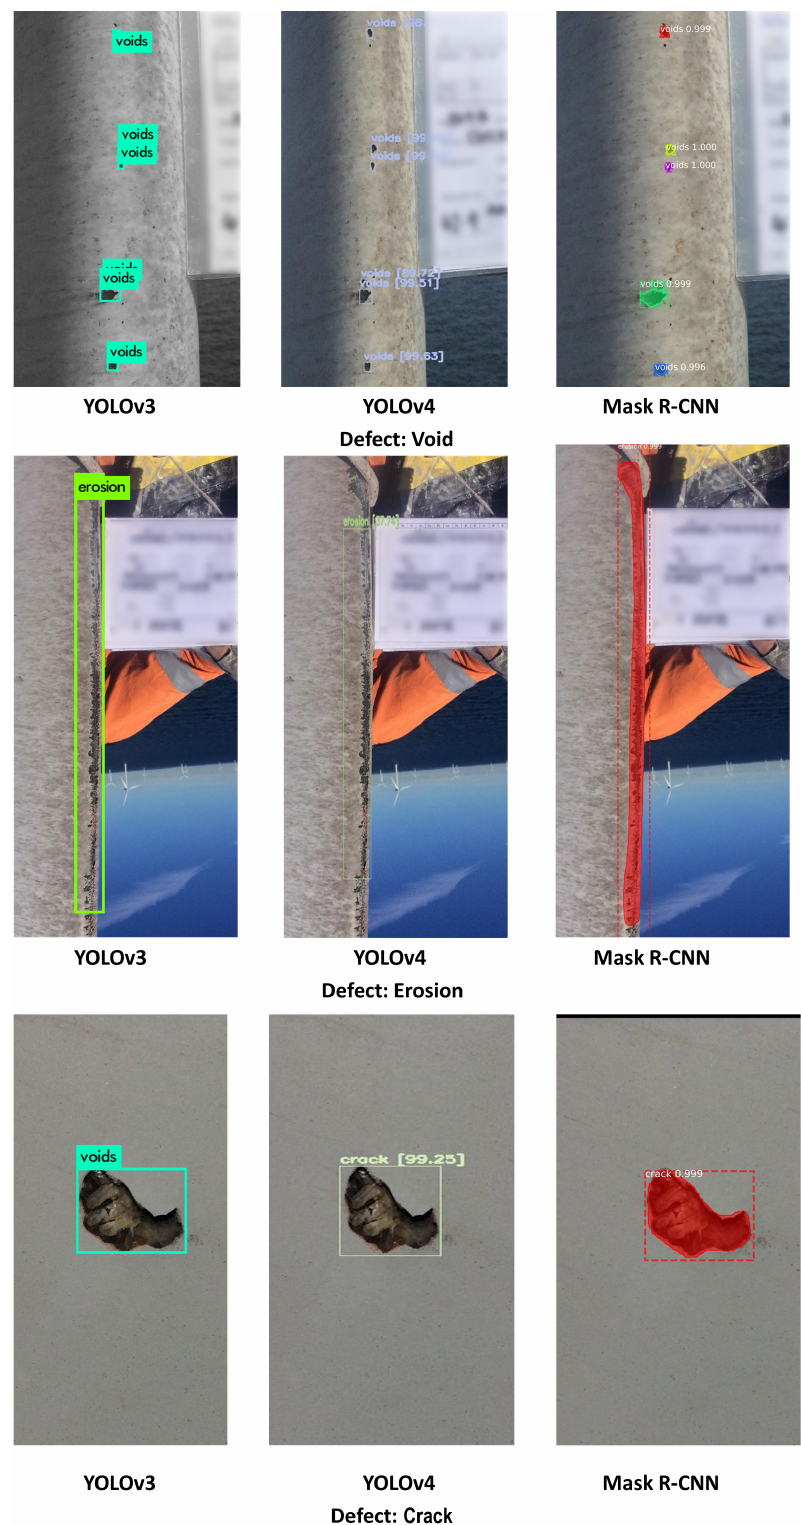
Figure 2. Example outputs of DL algorithms. The figure shows three outputs of YOLOv3, YOLOv4 and Mask R-CNN. All algorithms recognised the defects, however, YOLOv3 incorrectly classified a crack defect as a void defect; and the prediction boxes did not comprehensively cover the large-sized defect area, such as erosion defect, in